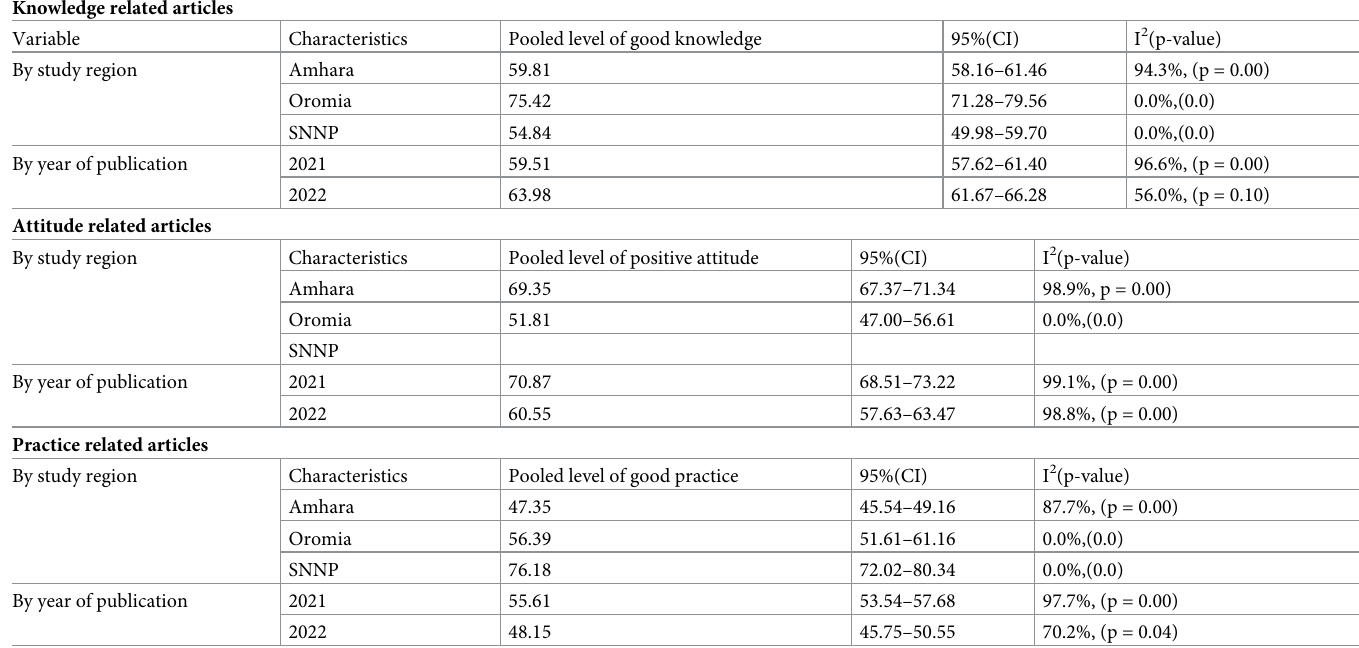
Table 2. Level of knowledge, attitude, and practice towards COVID-19 infection prevention among pregnant women in